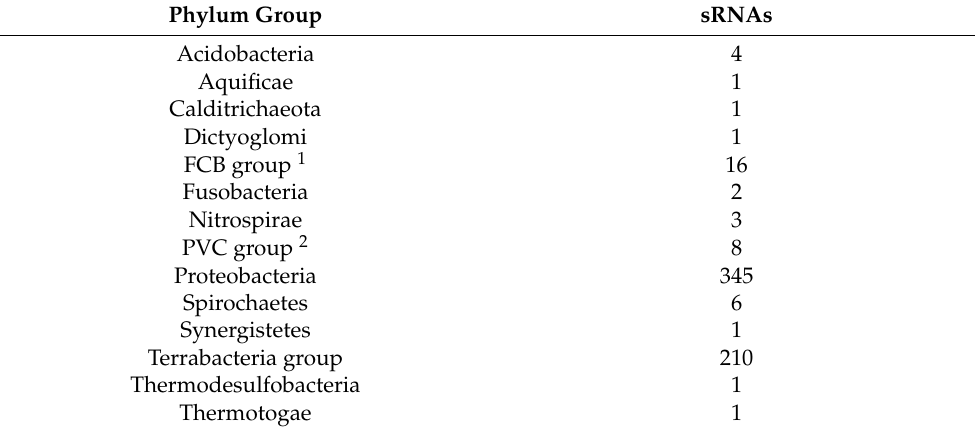
Table 1. Number of distinct annotated sRNAs in different phylum. Phylum Group sRNAs